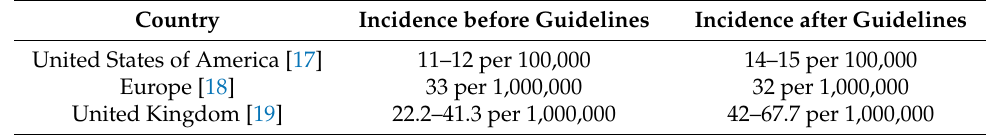
Table 2. Incidence of infective endocarditis.